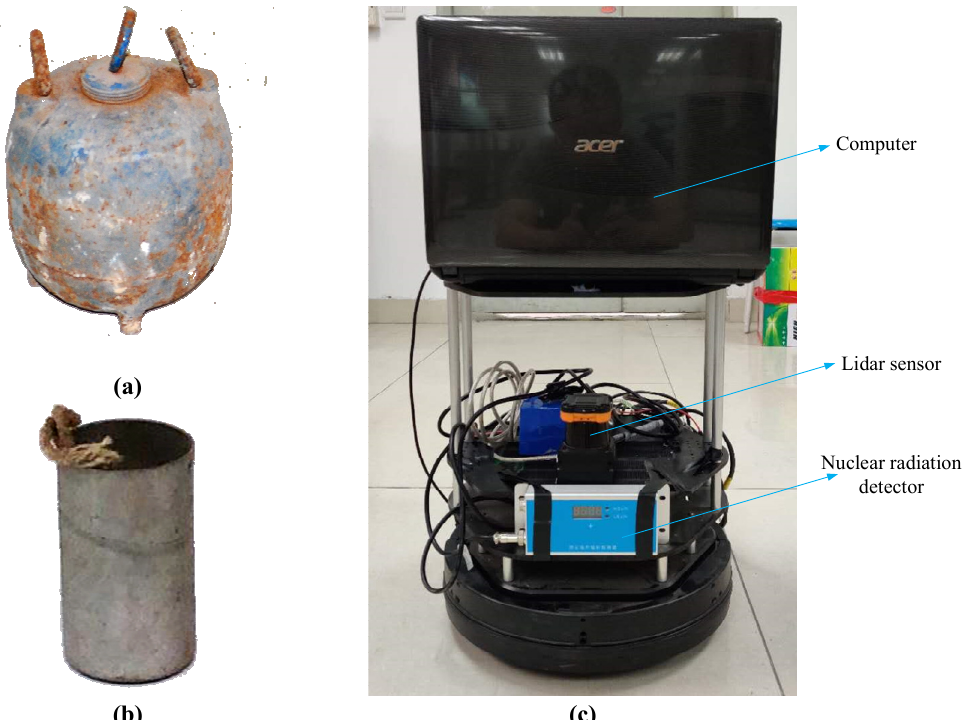
Figure 4. Physical picture of radioactive source and robot system. ( a ) Lead can. ( b ) Radioactive source. ( c ) Robot system.